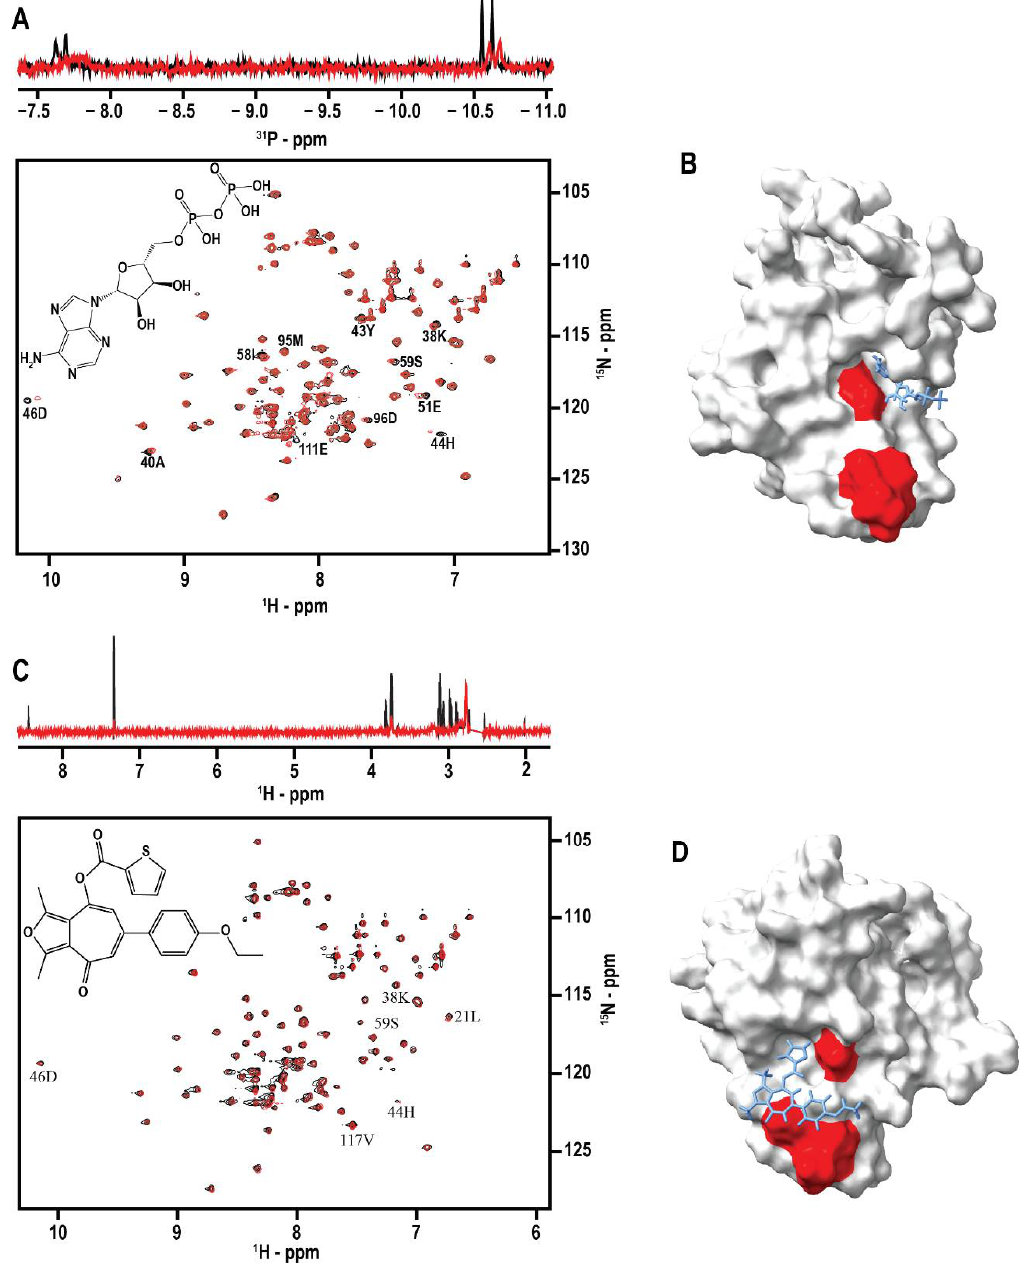
Figure 2. NMR Evaluation of Ligand Binding to DNAJA1-107. ( A ) (top) Overlay of 1D 31 P spectra of ADP in the presence (red) and absence (black) of DNAJA1. The significant line-broadening of the ADP phosphorus NMR resonances is indicative of protein binding. (bottom) Overlay of the 2D 1 H- 15 N HSQC spectra of apo-DNAJA1-107 (black) and DNAJA1-107 bound to ADP (red). ( B ) Surface rendition of the DNAJA1-107 NMR solution structure with residues experiencing an ADP-induced CSP colored red. ADP is shown as a licorice drawing in its MVD predicted binding pocket. ( C ) (top) Overlay of the 1D STD spectra of compound 7727968 in the presence (red) and absence (black) of DNAJA1-107. The observation of NMR resonances only in the STD experiment in the presence of DNAJA1 is evidence of compound 7727968 binding DNAJA1. The residual DMSO solvent peak at 2.8 ppm was removed from the spectra for clarity. (bottom) Overlay of the 2D 1 H- 15 N HSQC spectra of apo-DNAJA1-107 (black) and DNAJA1-107 bound to 7727968 (red). ( D ) Surface rendition of the DNAJA1-107 NMR solution structure with residues experiencing a 7727968-induced CSP colored red. 7727968 is shown as a licorice drawing in its MVD predicted binding pocket.